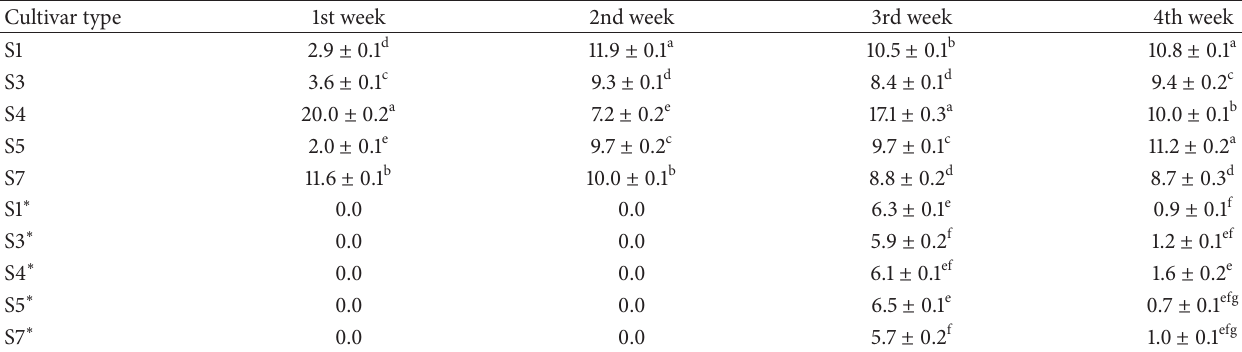
Table 5: Syneresis (%) of starch gels within four week refrigerated storage. Cultivar